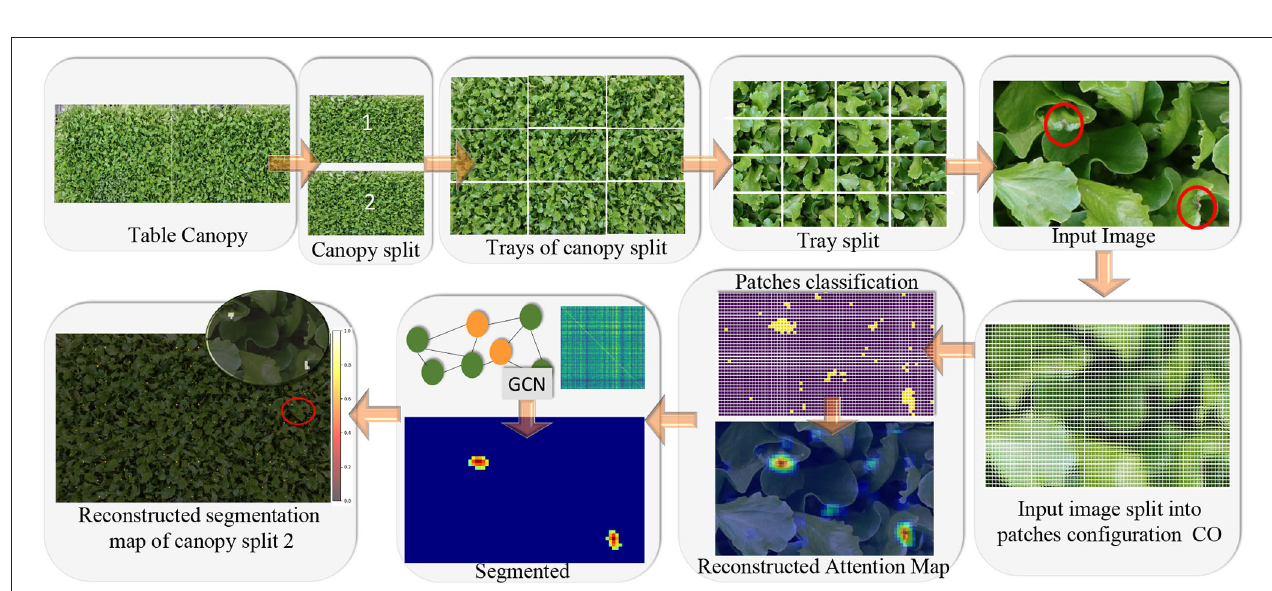
FIGURE 4 | Main idea of the tip-burn semantic segmentation requiring only image-level class annotation: decompose table canopy images up to an image X of size 352 × 576 × 3. Split X into overlapping patches of size 64 × 64 × 3 and use classification trained on these patches to obtain an attention map. Use the attention map as supervision for training a convolutional graph transferring probabilities on similar patches. Finally, results are automatically merged together forming the segmentation map of the canopy.